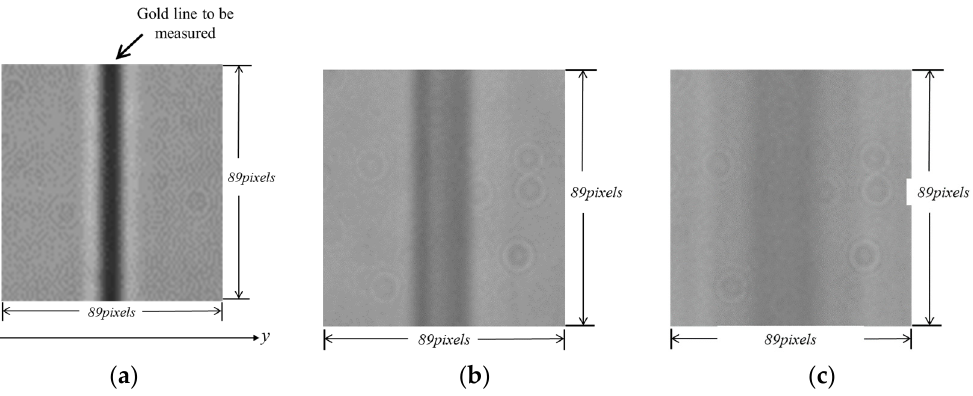
Figure 4. The TSOM cube consists of a series of images collected by through-focus scanning, as shown by the yellow cube. The optical axis is along the z direction of the coordinate system and the imaging plane is parallel to the xoy plane while scanning.